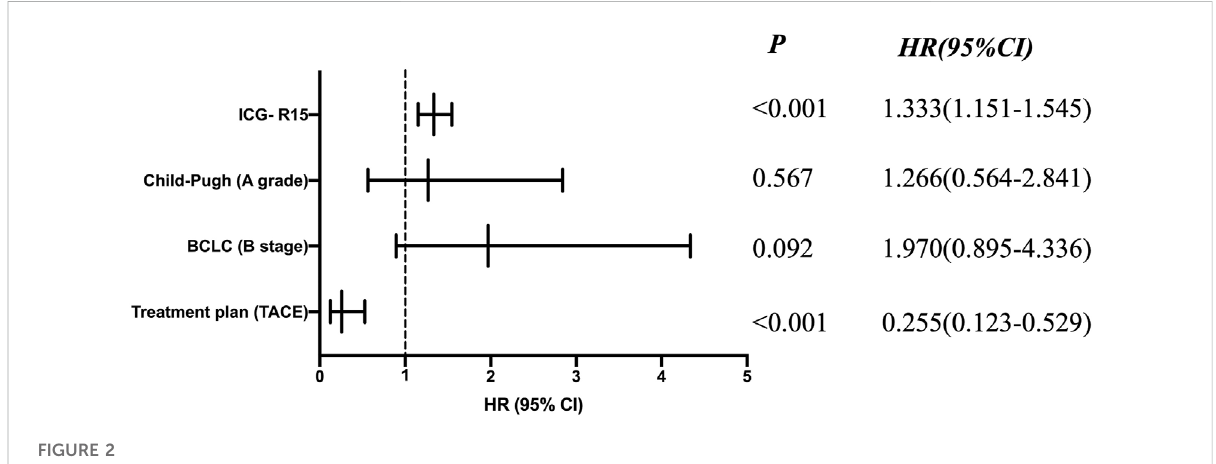
FIGURE 2 COX proportional hazard analysis for